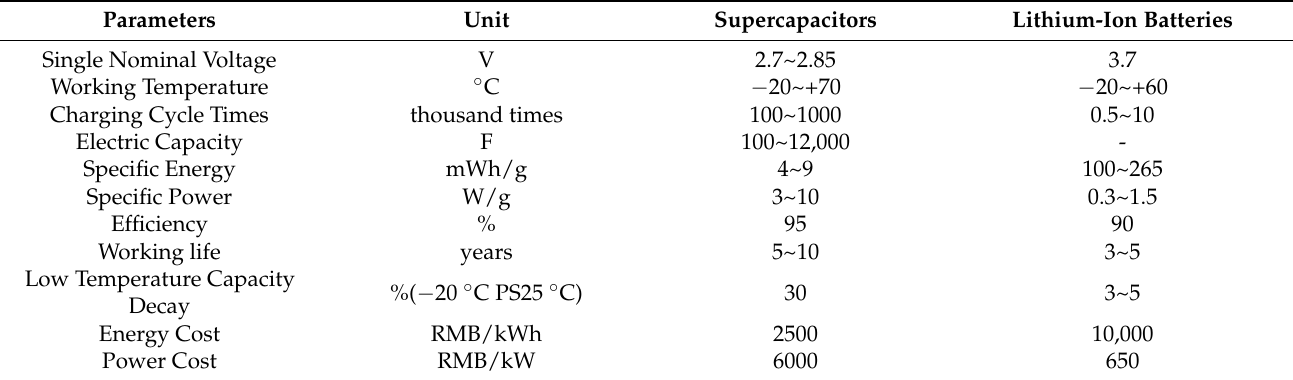
Table 1. Comparison of Performance Parameters between Supercapacitor and Lithium-ion battery